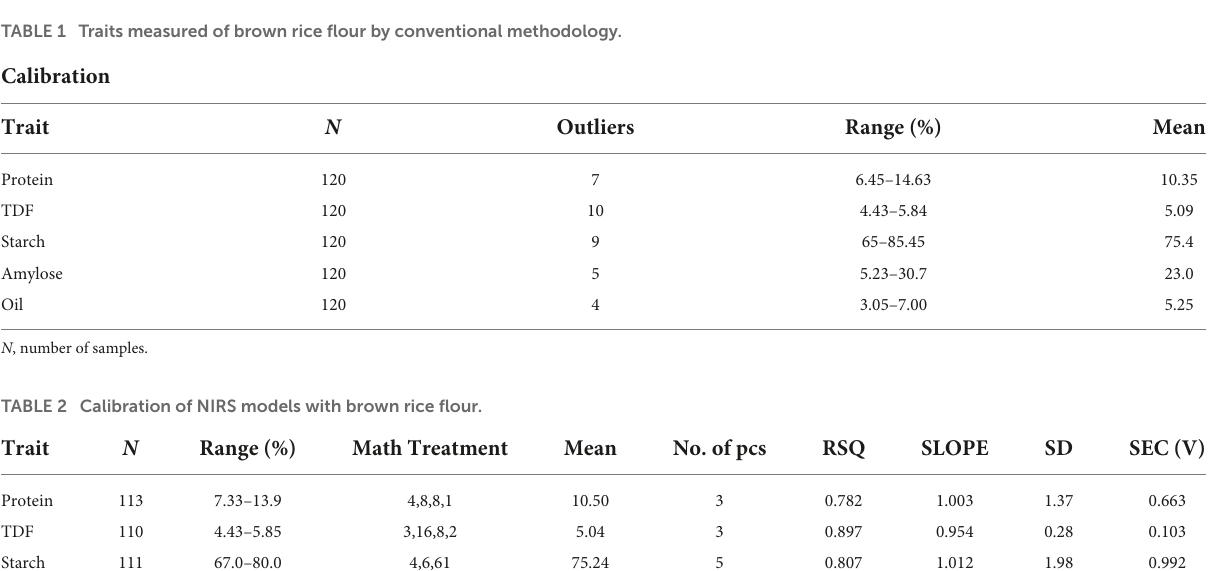
TABLE 1 Traits measured of brown rice flour by conventional methodology.